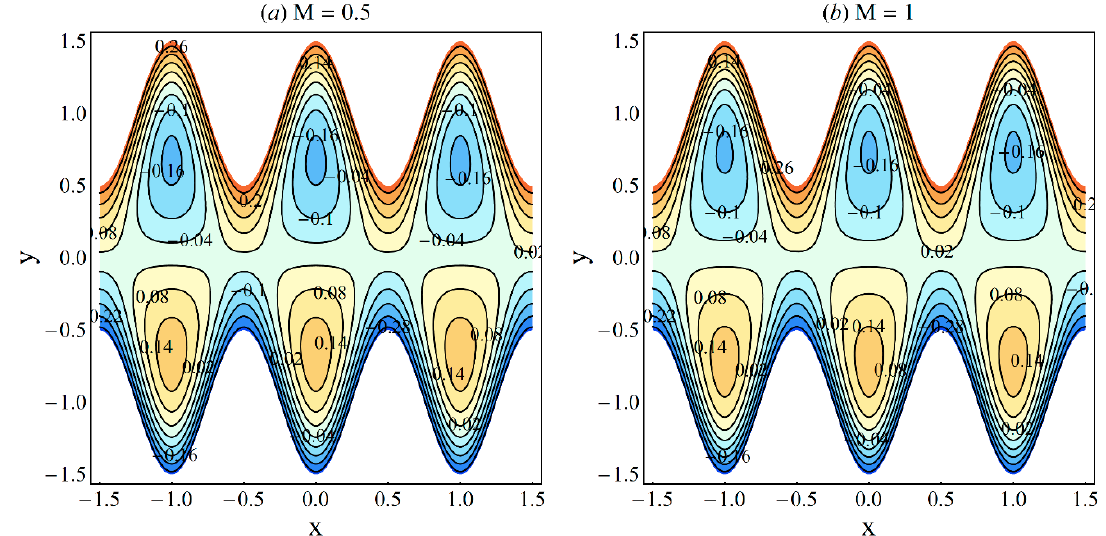
Figure 32. Streamlines for two different values of M , when α = 0.2 , ϕ = 0.01 , ε = β = 0.5 , ξ = 0.02 , η = 1, Q = 0.4: (a) M = 0.5; (b) M = 1.